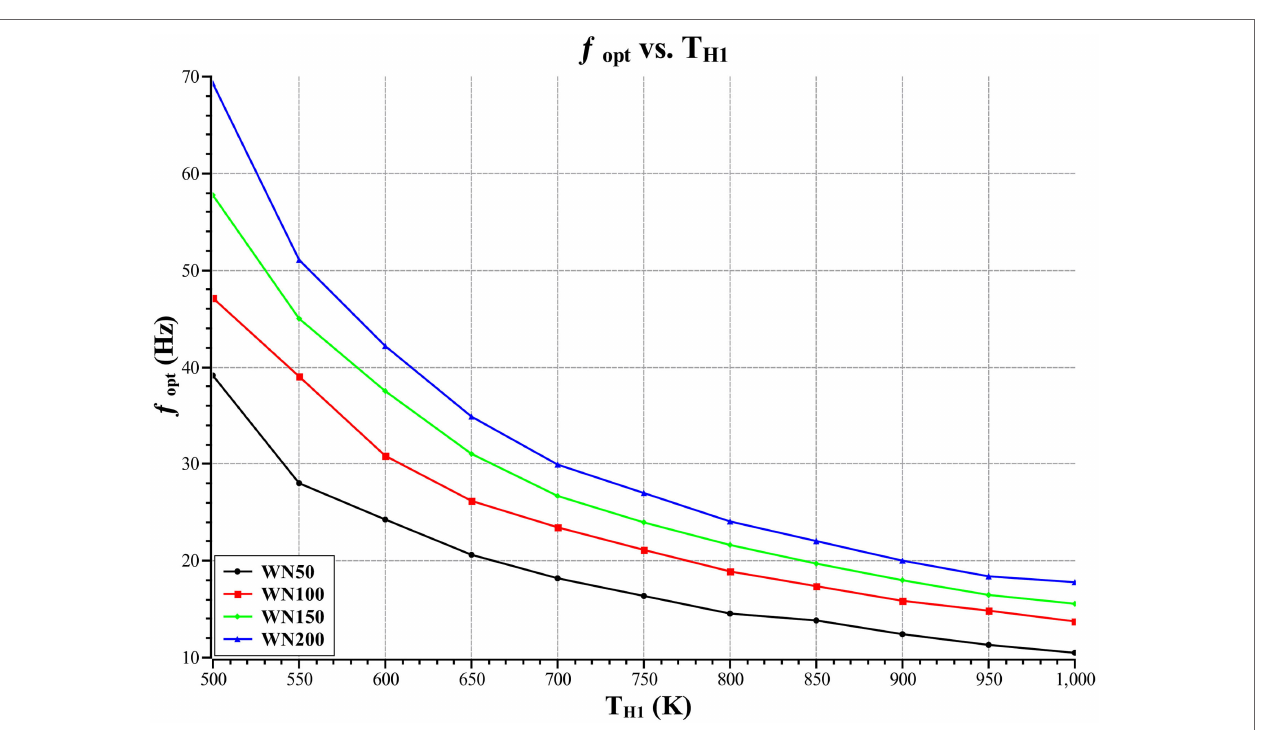
FIGURE 12 | Optimal operating frequency versus heater inlet